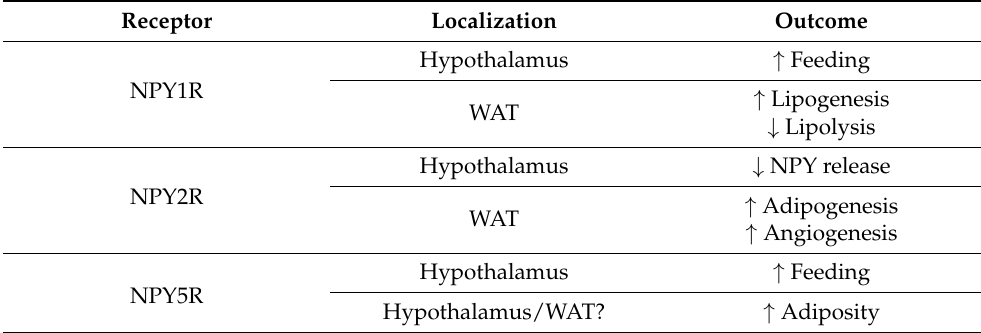
Table 1. Summary table of NPY receptors-mediated actions according to localization: Hypothalamic and in white adipose